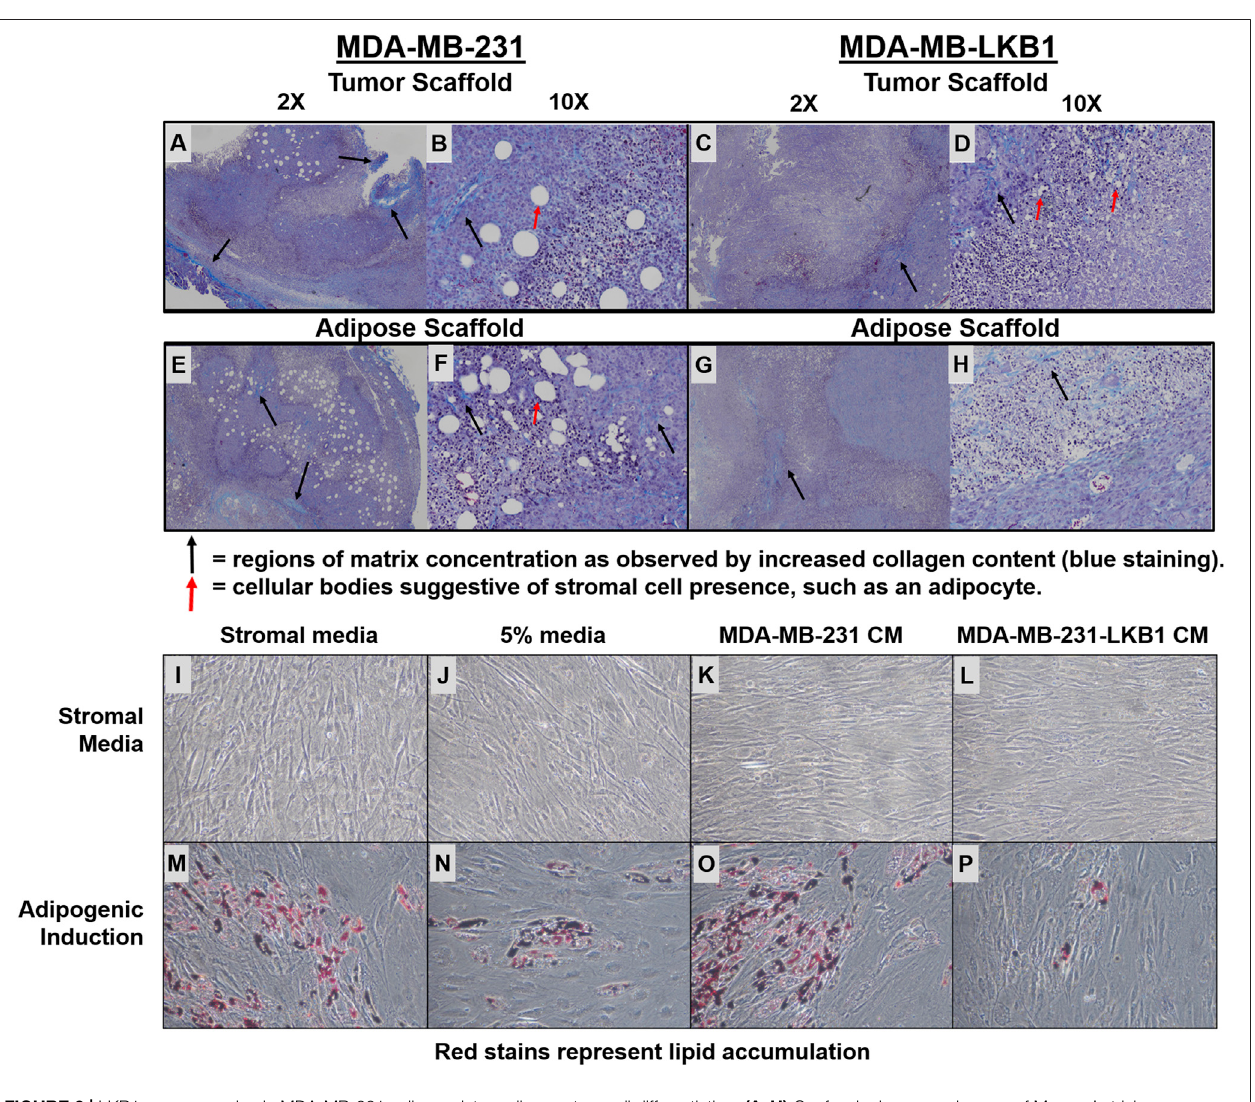
FIGURE 3 | LKB1 overexpression in MDA-MB-231 cells regulates adipose stem cell differentiation. (A – H) Confocal microscopy images of Masson ’ s trichrome (Collagen) staining of (A – B) MDA-MB-231 cells seeded on tumor scaffold at ×2 and ×10 magni fi cation, (C – D) MDA-MB-231-LKB1 cell-based tumor seeded on tumor scaffold at ×2 and ×10 magni fi cation, (E – F) MDA-MB-231 cells seeded on the adipose scaffold at ×2 and ×10 magni fi cation, and (G – H) MDA-MB-231-LKB1 cells seeded on the adipose scaffold at ×2 and ×10 magni fi cation. Masson ’ s trichrome stain: cytoplasm (red), collagen (blue), and nuclei (dark brown). Black arrows highlight regions of matrix concentration as observed by increased matrix staining (blue staining). Red arrows highlight larger cellular bodies suggestive of stromal cell presence, such as an adipocyte. (I – P) Phase contrast images of hASCs stimulated with (I,M) stromal medium, (J,H) 5% medium, (K,O) MDA-MB-231-conditioned medium, or (L,P) MDA-MB-231-LKB1-conditioned medium for 3 days. Cells were then either maintained in stromal medium (I – L) or induced to an adipogenic phenotype with adipogenic medium (M – P) for 7 days. Images obtained at ×10 objective. Lipid vacuoles will stain red when present, suggestive of adipogenic differentiation. CM = condition